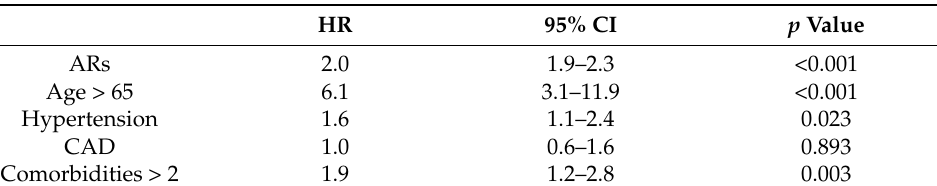
Table 2. Baseline characteristics used for the multivariate analysis. ARs = arrhythmias; CAD = coronary artery disease.